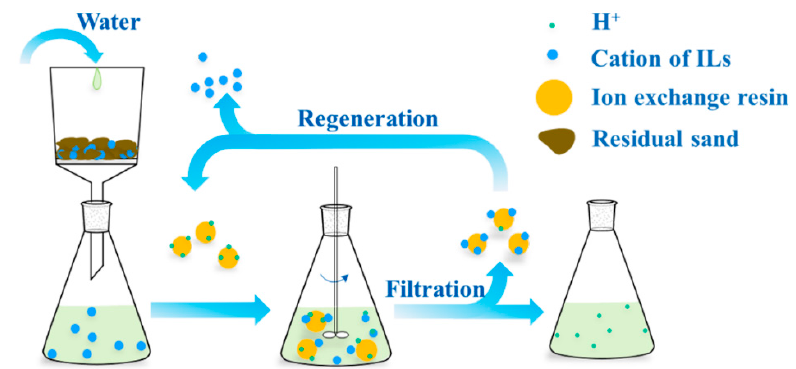
Figure 2. Schematic of the removal of ionic liquids from residual sands by washing–ion exchange combined process.